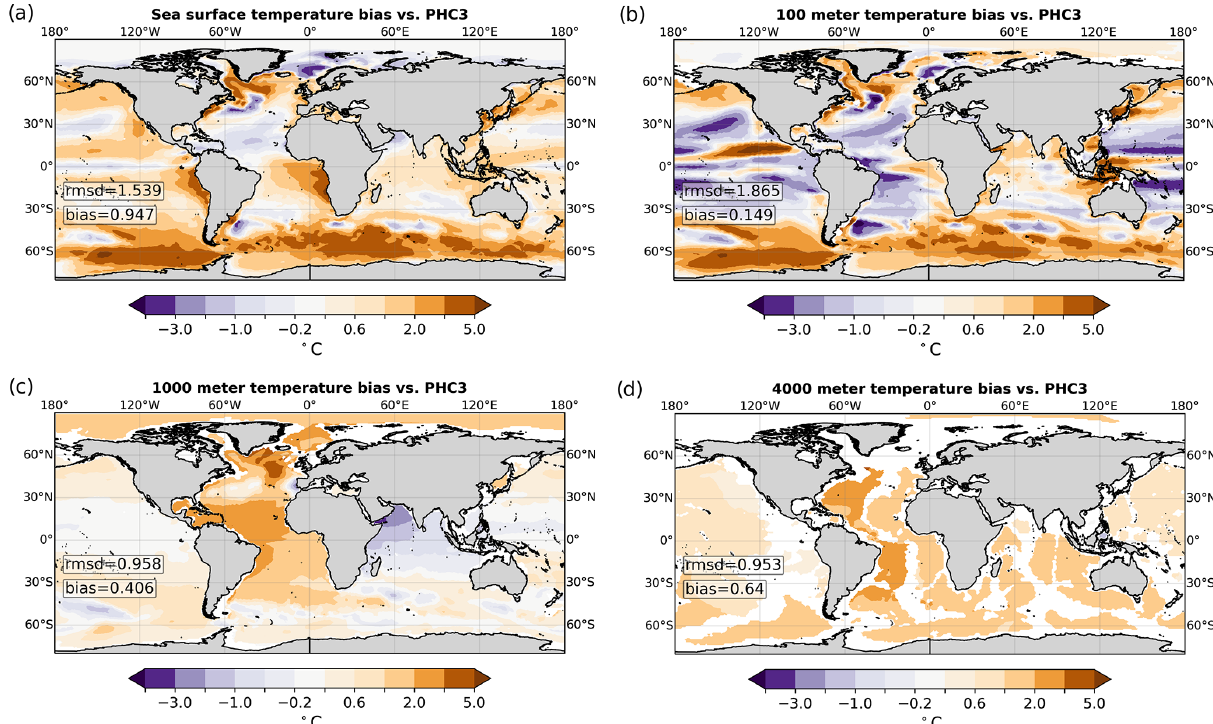
Figure 8. Mean ocean temperature bias of the last 25 years of the historical simulation with respect to PHC3 at (a) 0, (b) 100, (c) 1000, and (d) 4000m depth. For each depth rmsd gives the area-weighted root mean square distance between observations and model data, and bias gives the area-weighted mean distance. At the surface the ocean-resolution-specific warm biases in upwelling regions and western boundary currents can be seen, in addition to a pronounced Southern Ocean warm bias. At depth, a warm bias dominates in the